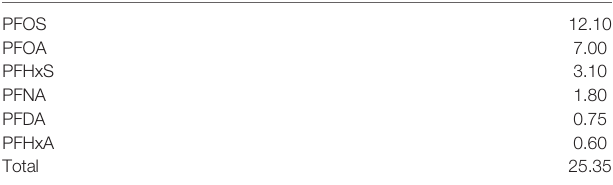
TABLE 1 | PFAS mixture (ng/g) administered to cell cultures based on levels in blood samples collected from residents of Pittsboro, North Carolina.